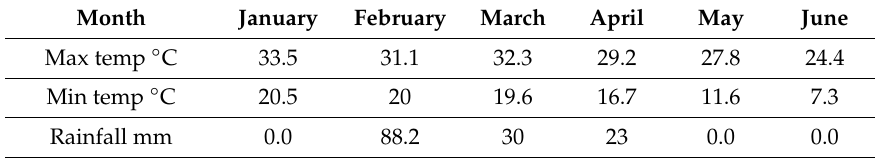
Table 1. Monthly rainfall and mean temperatures in Bale village recorded in 2019.